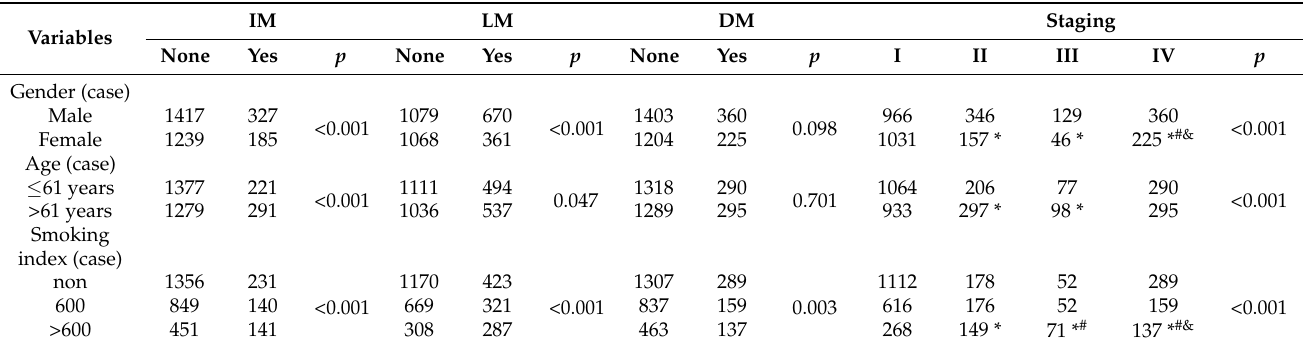
Table 2. The correlation of age, sex, and smoking index with tumor metastasis, and stage of patients with